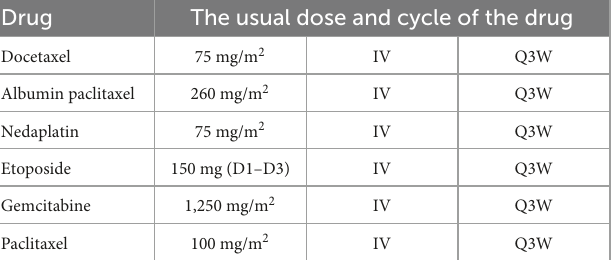
TABLE 3 Traditional chemotherapeutic drugs and their commonly used methods.